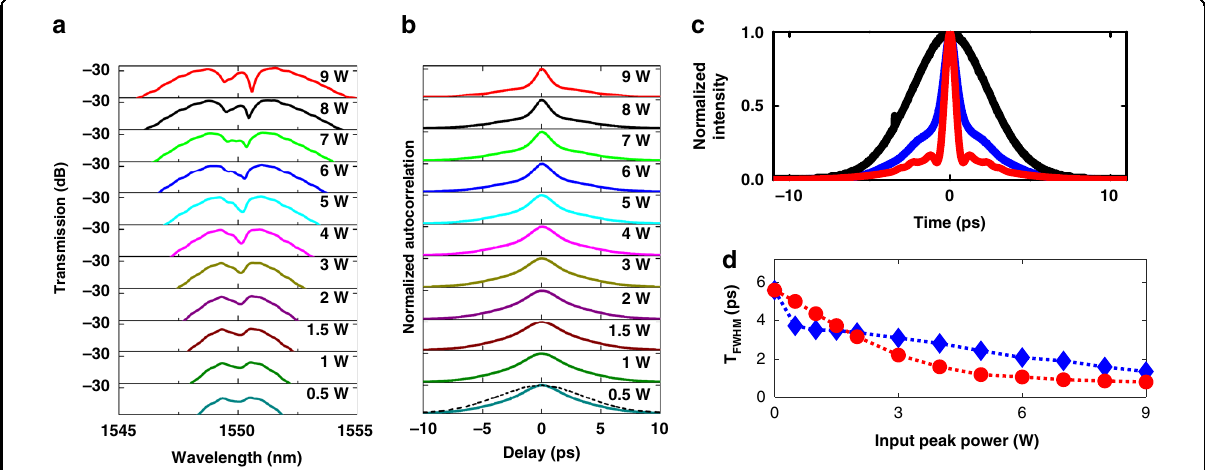
Fig. 7 Experimental demonstration of temporal compression using Device 2 ( β 2(grating) = − 890 ps 2 m − 1 ). The measured ( a ) output spectra ( b ) and temporal traces of the USRN compressor. The dashed line in ( b ) shows the temporal trace for input laser. c The measured (blue) and theoretical temporal pulses (red) is plotted along with input pulse (black) at P peak(in) = 9 W (pulse energy = 50.4 pJ). d Measured pulse width (blue diamonds) as a function of P peak(in) fi tted by theory (red circles). The theory is extracted from Fig.